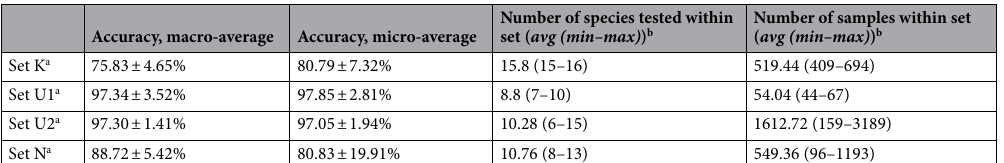
Table 2. Accuracy metrics for the known, unknown, and novel unknown species sets over twenty-five-fold validation. a Set K species are known to the closed-set CNNs. Set U1 unknown species are used in training for Tiers I, II & III. Set U2 unknown species are used to train Tier II&III. Set N unknown species are novel to all tiers and reserved for testing. b The extreme variation in the test set was due to class balancing the Tier II&III training data, such that whenever a genus was represented in the K set a similar number of specimens from that genus were available for the unknown training set, whenever possible. Some of the U2 species were only used during training due to limited numbers of specimens in particular